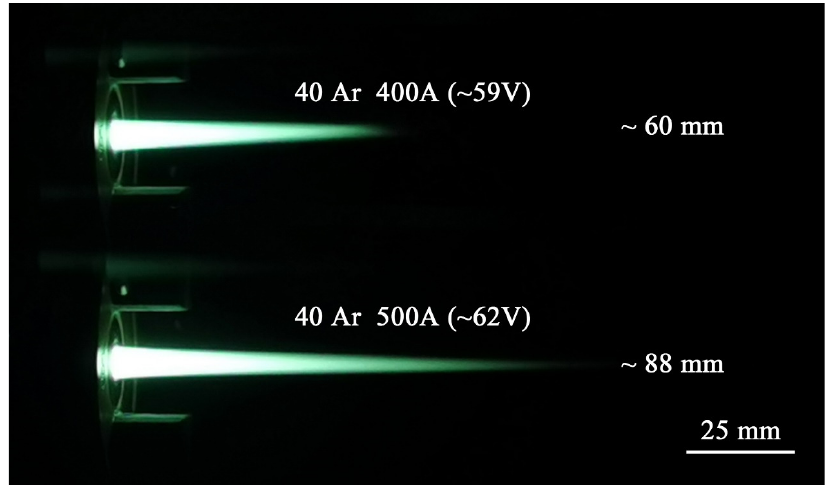
Figure 6. Experimentally observed plasma jets generated by SinplexPro™ plasma spray gun.